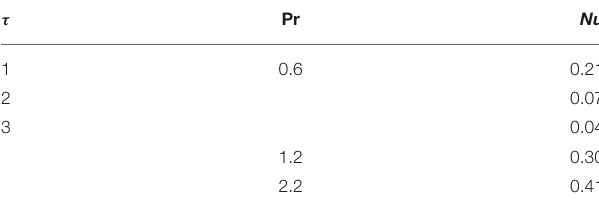
TABLE 2 | Effect of variation of different variables on Nu. τ Pr Nu